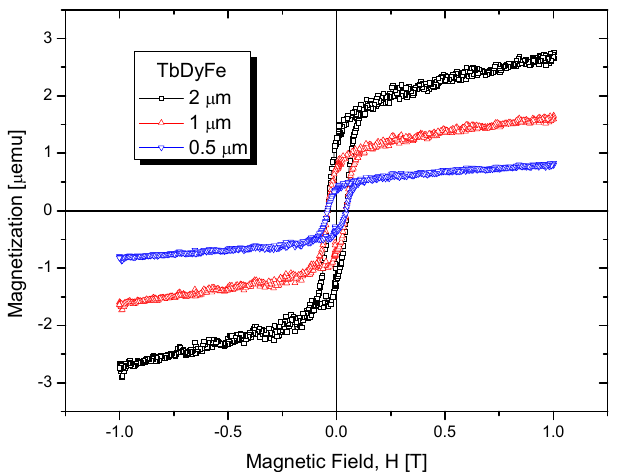
Figure 7. Magnetization of TbDyFe mirror at each film